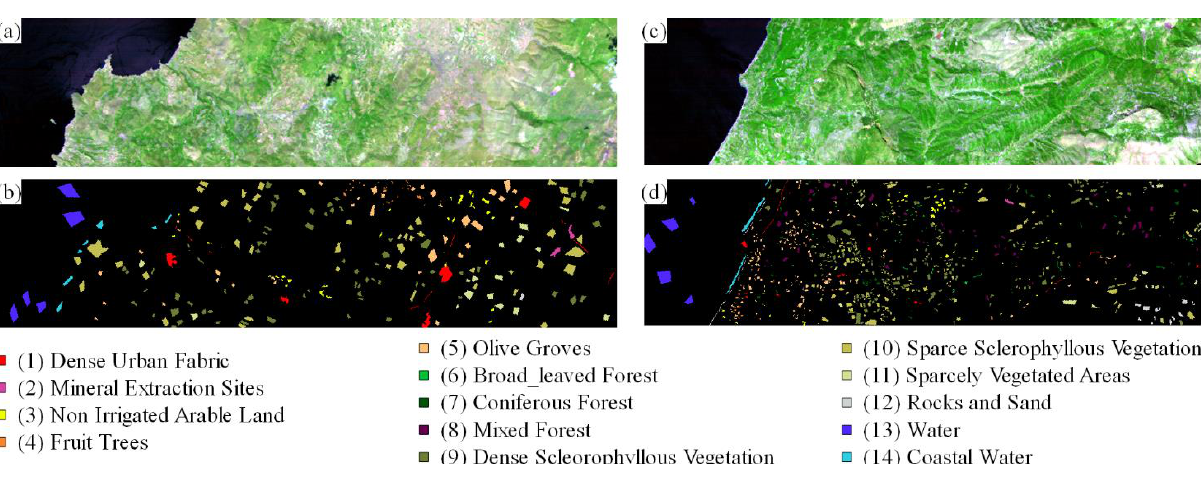
Figure 1. (a) Dioni image composition B25G90R160 (b) Dioni ground truth (c) Loukia image composition B25G90R160 (d) Loukia ground